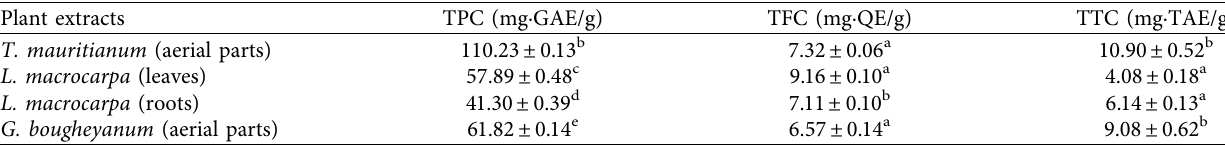
Table 2: Total phenol, favonoid, and tannin contents of plant extracts.